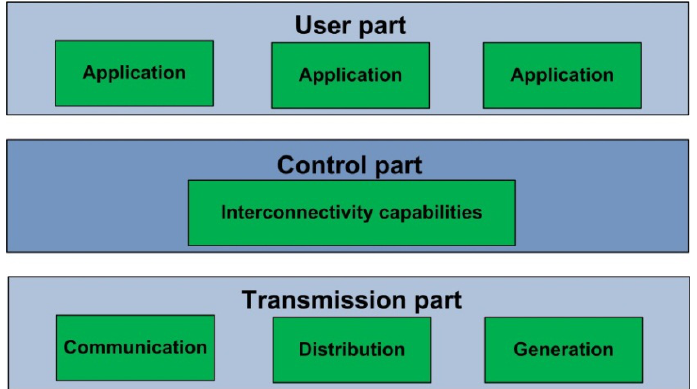
Figure 4. Service-Oriented Middleware for Smart Grid, as described in [20].